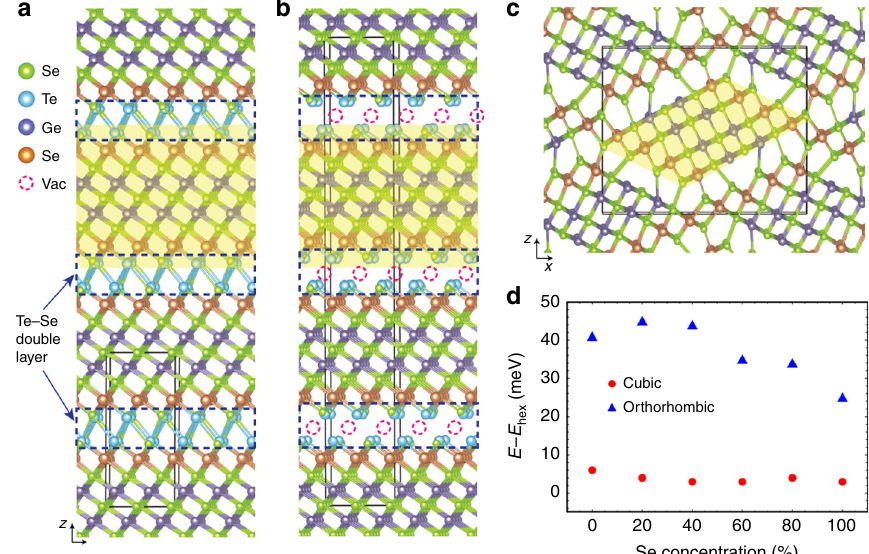
Fig. 1 Impact of Se substitution revealed by density functional theory (DFT) simulations. Atomic structures of a hexagonal Ge 2 Sb 2 Se 4 Te 1 (GSS4T1); b cubic GSS4T1; and c orthorhombic Ge 2 Sb 2 Se 5 with the representative atomic blocks highlighted by the yellow shaded areas. Unit cells, loosely bound Te/Se double layers, and aggregated vacancies are presented by the black boxes, dashed rectangle, and dashed circles, respectively. d Cohesive energies of the cubic and orthorhombic phases relative to their hexagonal counterparts with various Se concentrations